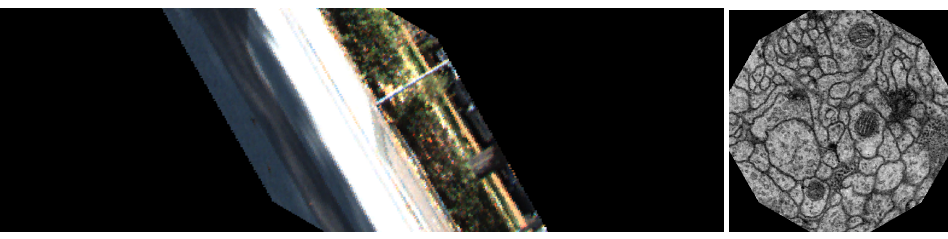
Figure 10. Visualization of three images from the KITTI (left) and EM (right) datasets, each rotated with a different